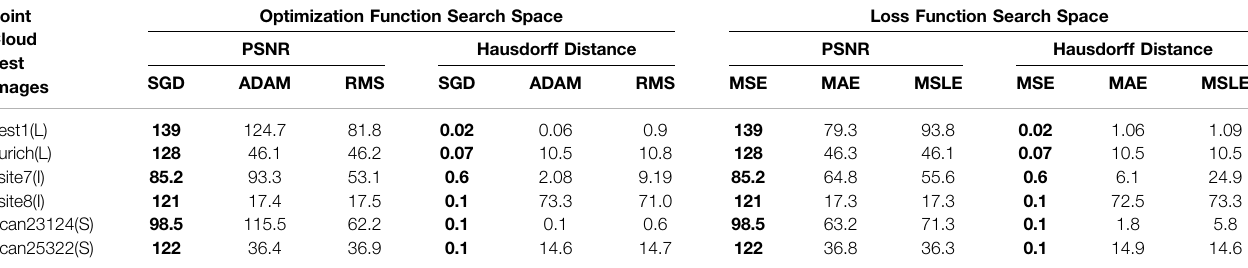
6000 epochs for getting better quality reconstructed image but the model reached the convergence state much earlier that is shown in Figure 4 . The DLQ network produces better target images that are shown in Figure 6 . The sample target (input) and actual output pcd